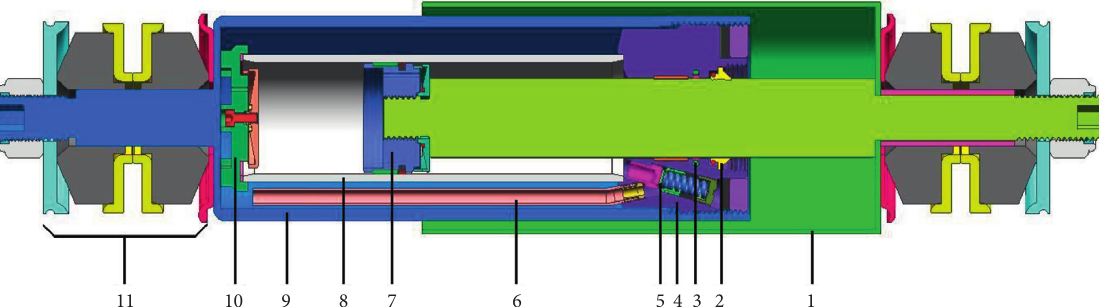
Figure 2: Internal structure of the yaw damper. (1) Protective cover. (2) Oil scraper ring. (3) Piston rod sealing device. (4) Piston rod orientation seat. (5) Damping valve. (6) Oil orientation tube. (7) Piston and piston rod composition. (8) Pressure cylinder. (9) Auxiliary chamber. (10) Foot check valve. (11) Joint connection structure.